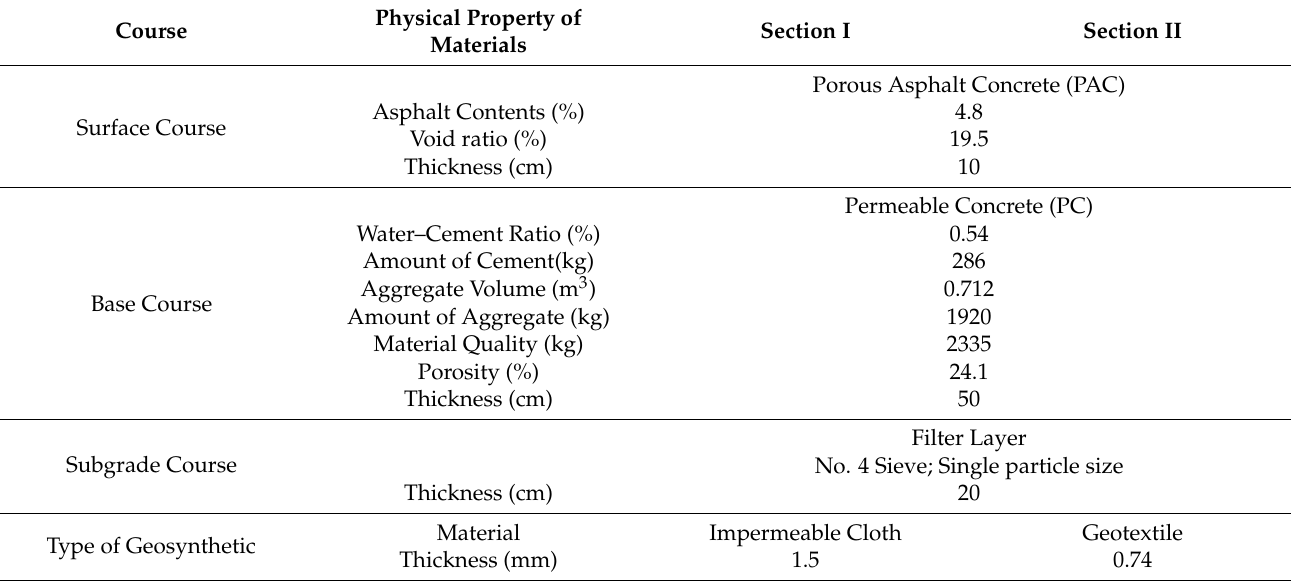
Figure 2. The pavement designs of this study. Table 1. Material Physical property of semi-permeable and fully permeable pavements.